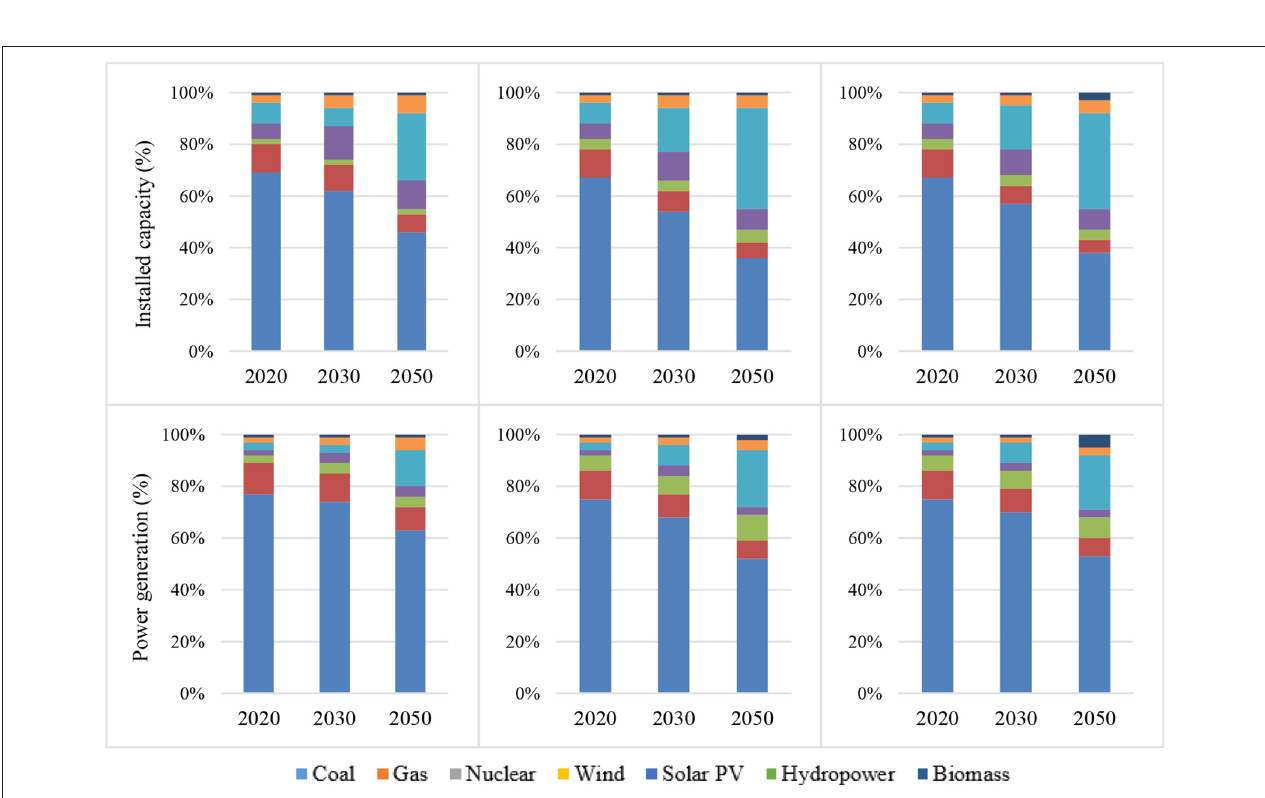
FIGURE 3 | Installed capacity and power generation (from left to right: LD, REF, and HD scenarios).